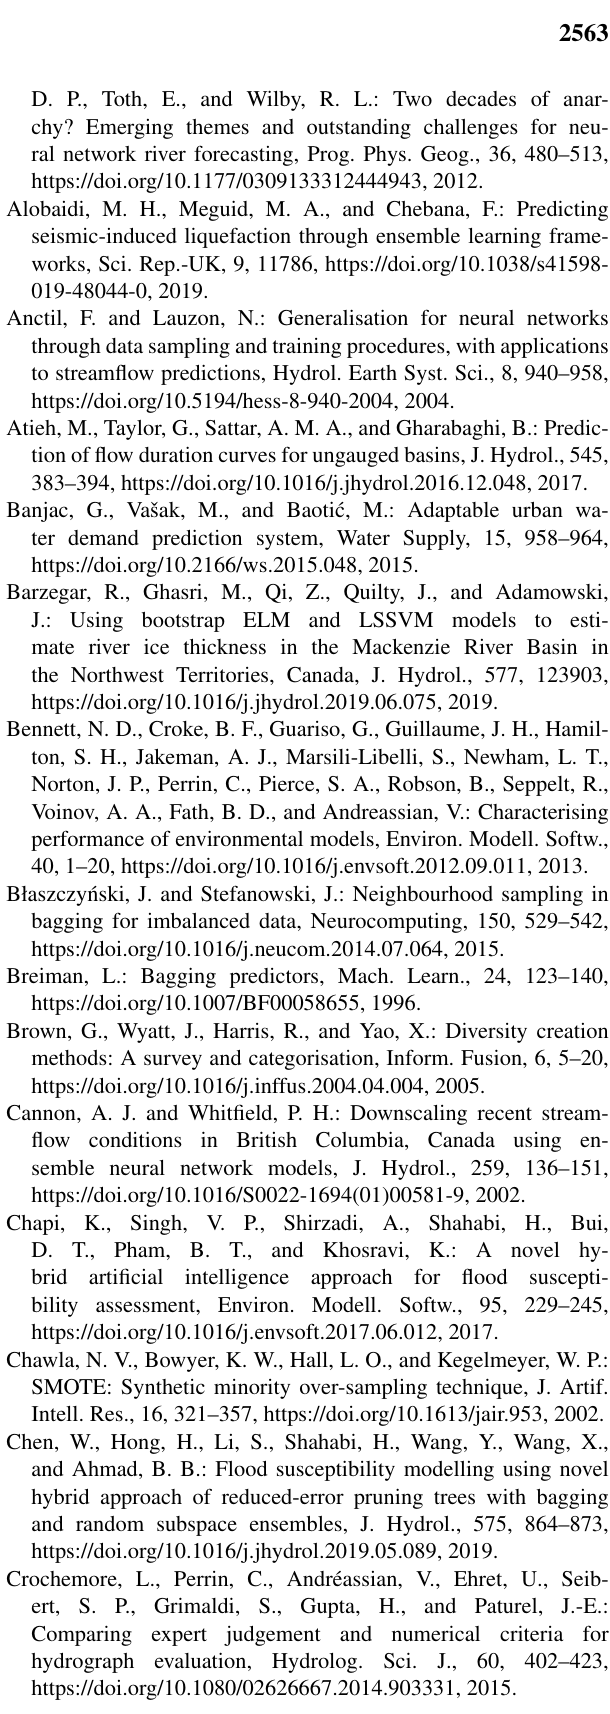
Figure 1 was produced using data from the following sources: Esri (aerial basemap Esri, 2020), DMTI Spatial Inc. accessed via Schol- ars GeoPortal (surface water and Bow River watershed boundary DMTI Spatial Inc., 2014a, b, c, 2019), and the TRCA (Don River watershed boundary Toronto and Region Conservation Authority, 2020b). Monitoring station locations were obtained from the meta- data for the respective temporal